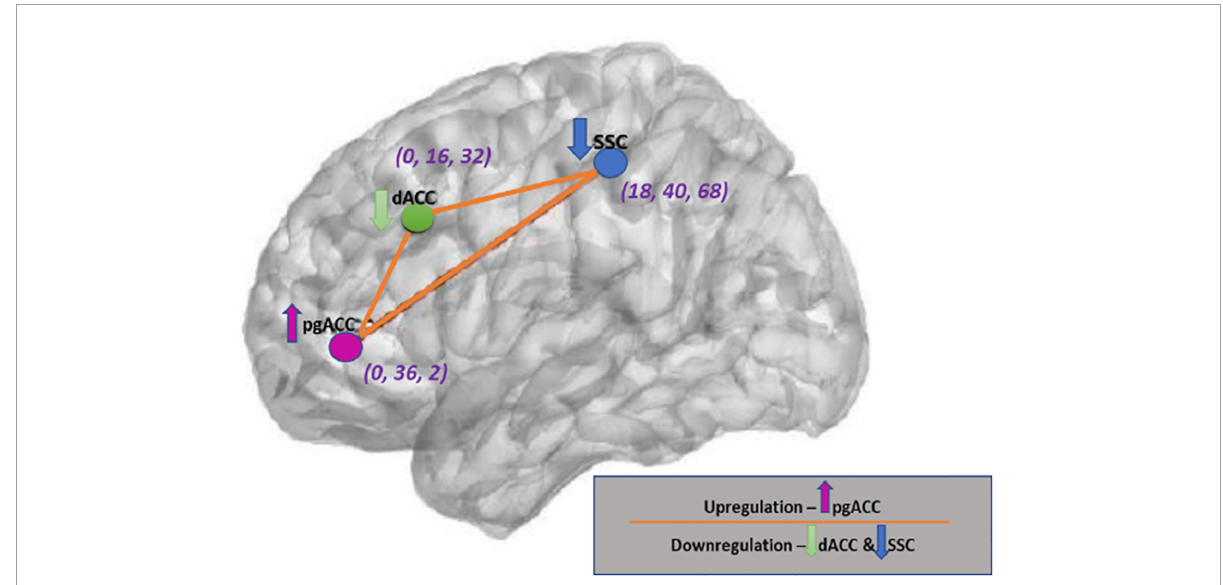
FIGURE1 The Regions of interests and neurofeedback training directions with respective coordinates (XYZ). This figure was created using brain images produced from eLORETA software and with the help of Microsoft PowerPoint application.